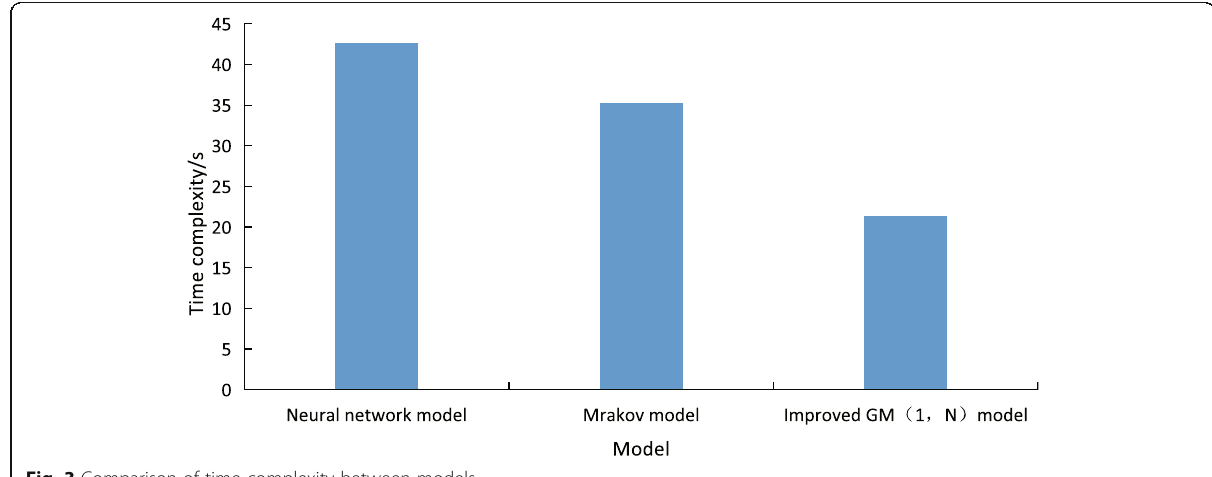
Fig. 3 Comparison of time complexity between